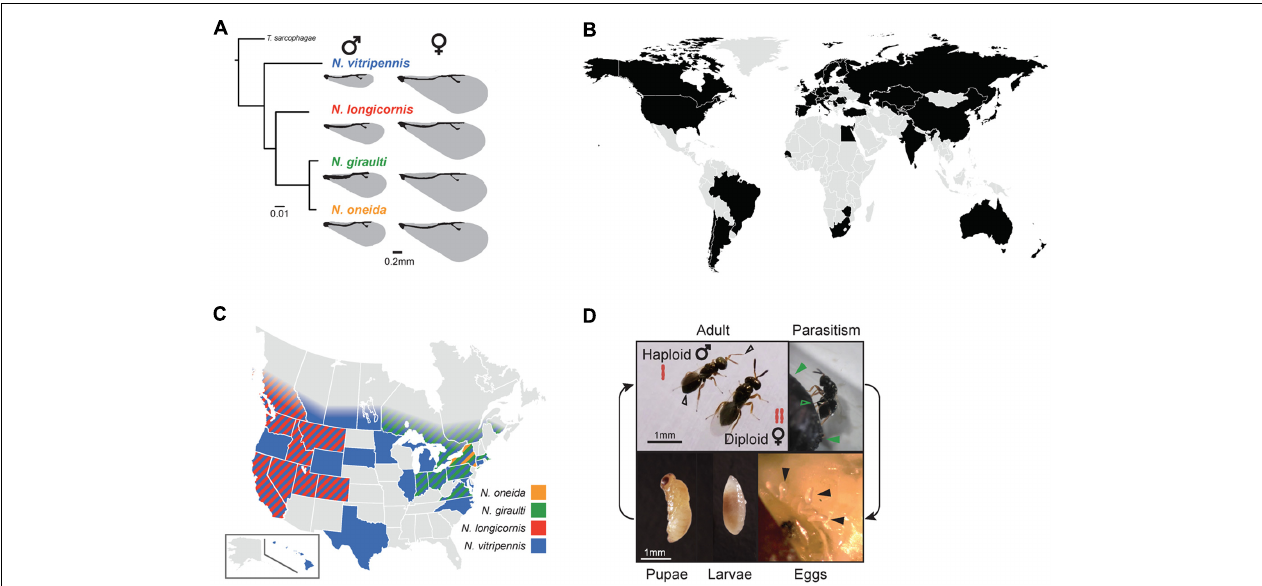
FIGURE 1 | (A) Phylogenetic relationships within the Nasonia species complex based on the CO1 gene. The parasitoid wasp Trichomalopsis sarcophagae was used as outgroup. The scale bar indicates substitutions per site. Note the morphological differences in wing size between species and genders (drawing based on Loehlin et al., 2010). (B) Countries in which Nasonia has been observed, based on published records of N. vitripennis [Universal Chalcidoidea Database (Noyes, 2016) and (Raychoudhury et al., 2009, 2010b; Paolucci et al., 2013)]. The gray color indicates countries for which no observations are documented, in most cases due to missing sampling information. For all countries except the US, records state that the observed species was Nasonia vitripennis – however, many of these observations were made before the discovery of the three younger species in the US. Therefore, this global map shows observations of Nasonia without distinguishing between species. (C) Observations of all four Nasonia species in the US and Canada, based on published information (Darling and Werren, 1990; Raychoudhury et al., 2009, 2010a,b). (D) Nasonia life cycle from oviposition to adulthood. Sex-specific differences in ploidy are indicated for adult males and females. Additional sexual dimorphisms include smaller wing size, less pigmented antennae and rounded abdomen in males (open black arrows). Parasitism is representing by a female wasp ovipositing into a fly pupa (closed green arrows: Fly pupa; open green arrows: Ovipositor of the wasp). Embryos are approximately 100 µ m by 500 µ m in size (closed black arrows). The Nasonia larva and pupa were photographed outside of their fly host. Photo credit: Matthew C. Johnson ©